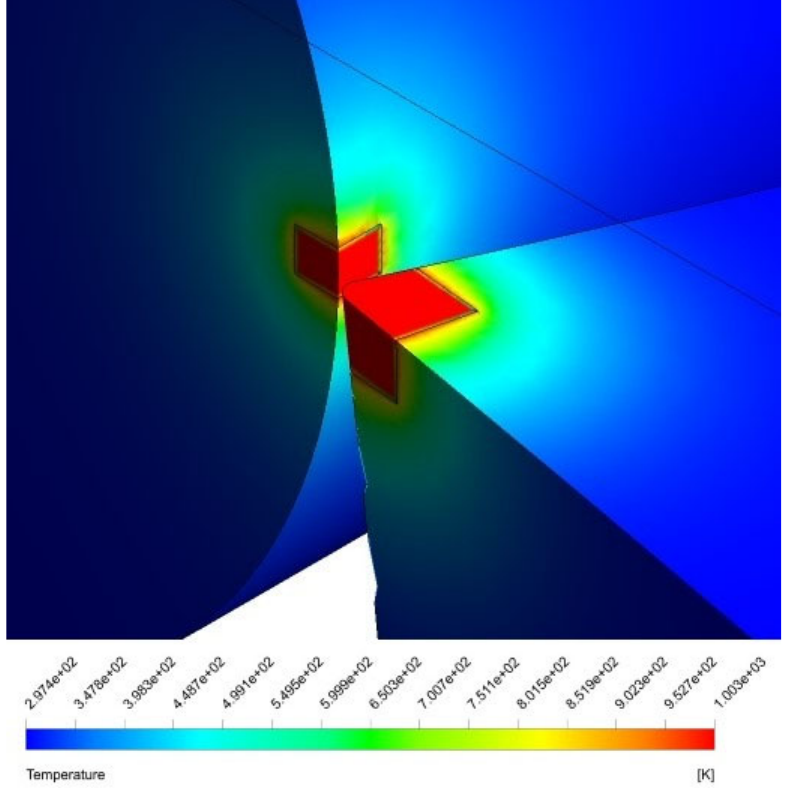
Figure 6. Variation in temperature with respect to distance from the cutting tool–workpiece inter ‐